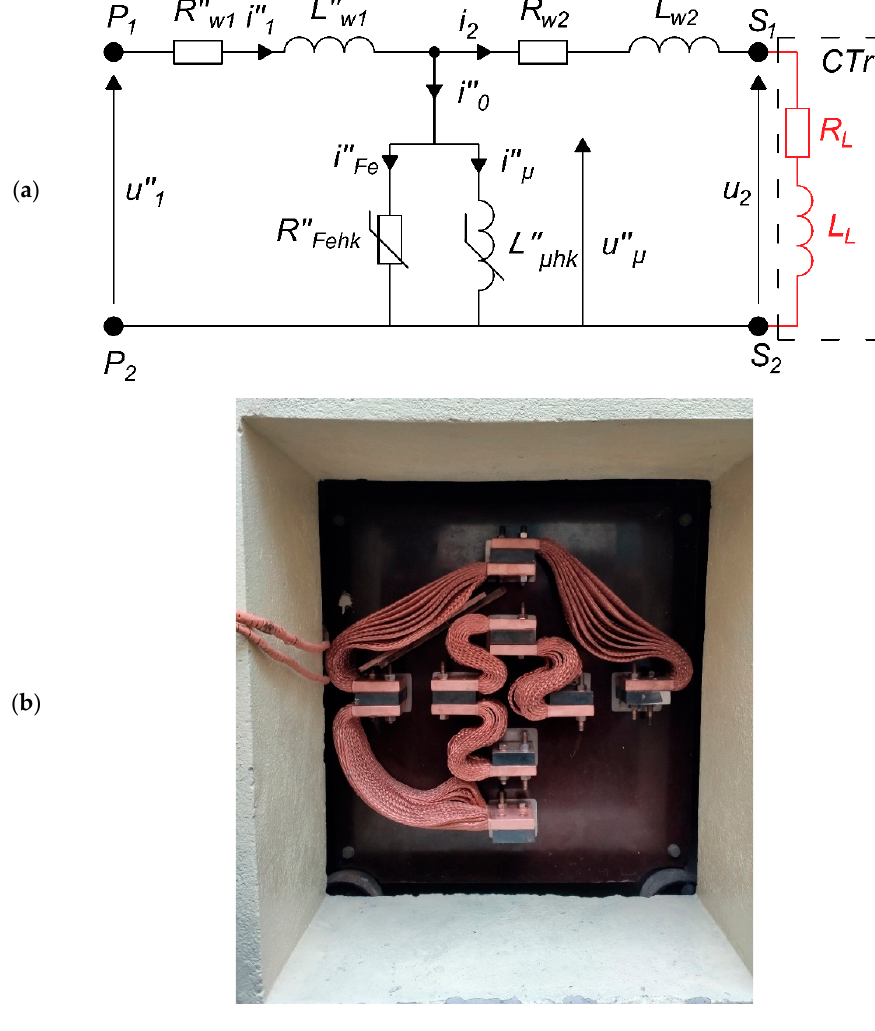
Figure 2. ( a ) Equivalent circuit of the HCT, ( b ) Photo of the HCT’s secondary side. In Figure 2, the following abbreviations are used: The notation ″ means that the values are converted to the HCT’s secondary side.